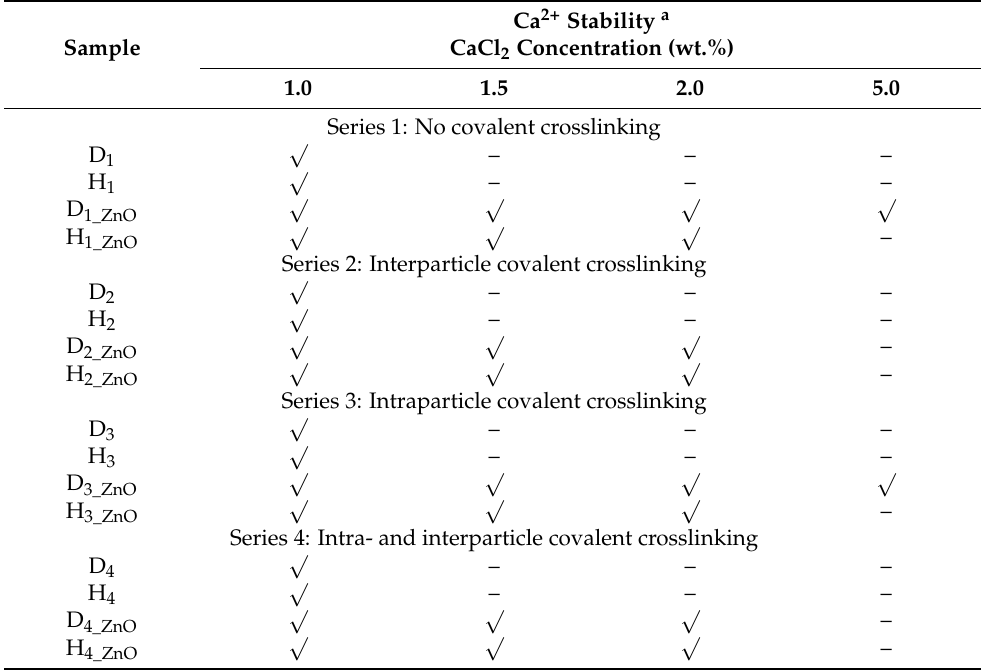
Table 6. Calcium ion stability results of latexes, differing in the covalent crosslinking strategy, surfactant type and nanostructured ZnO